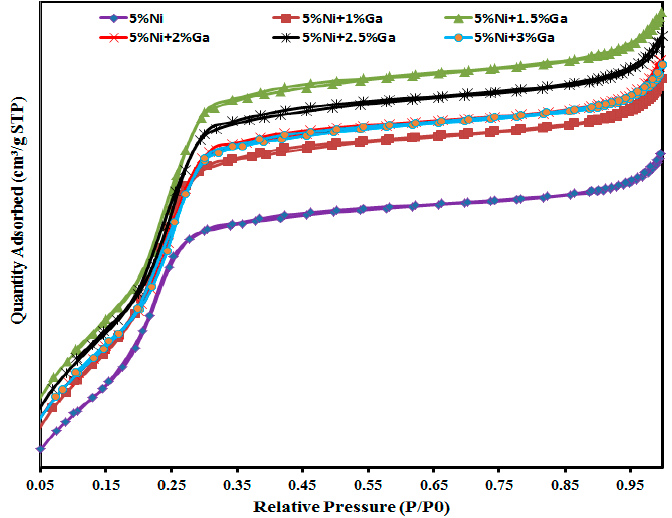
Figure 1. N 2 adsorption–desorption isotherms of fresh tested catalysts. Table 1. Characterization of the catalysts used for methane reforming Catalyst